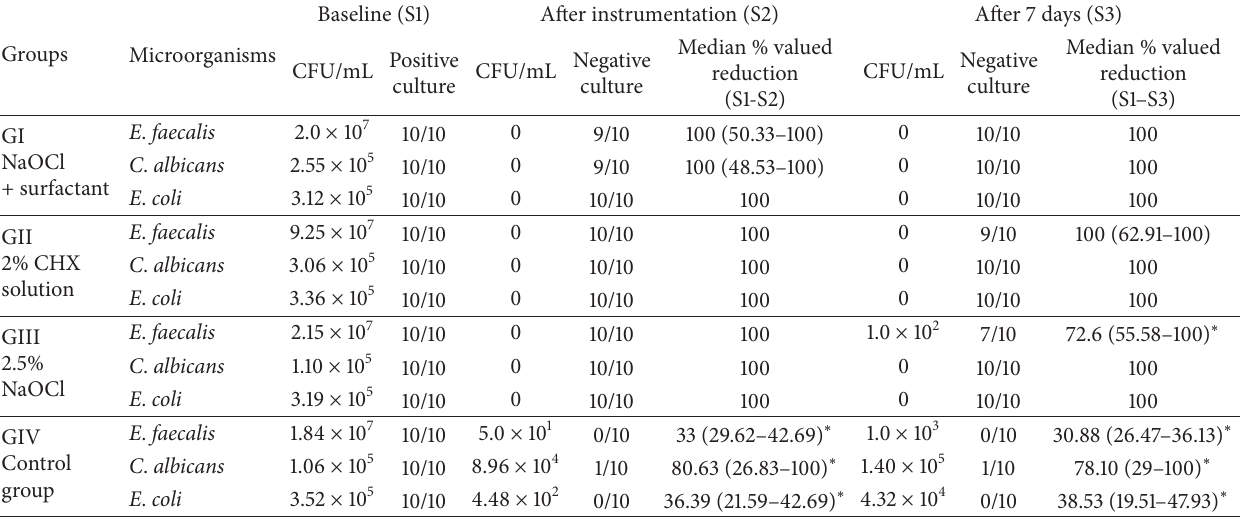
Table 1: Distribution of the median colony-forming unit (CFU/mL) and median percentage of bacterial load reduction found at all different sampling times (S1, S2, and